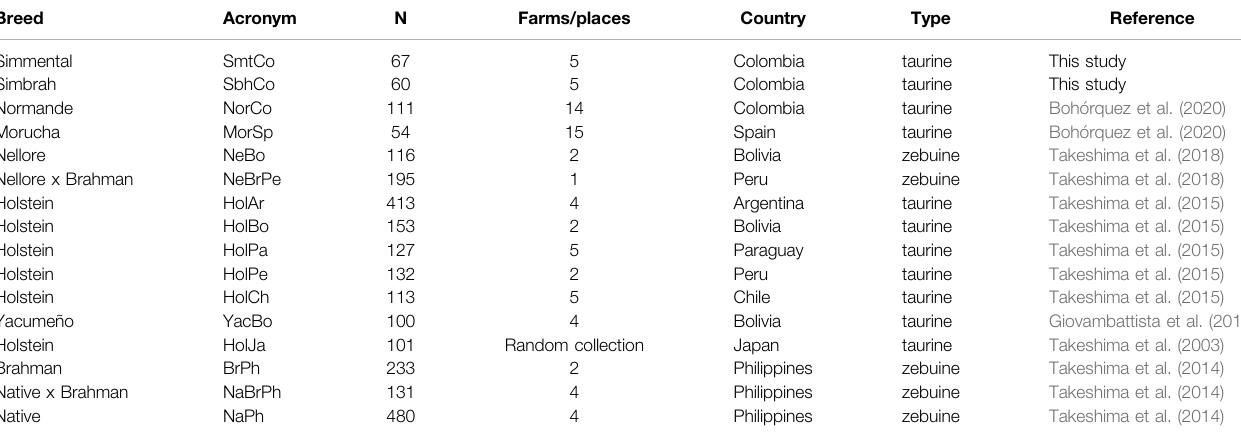
TABLE 1 | General information regarding the 16 cattle populations analyzed in this